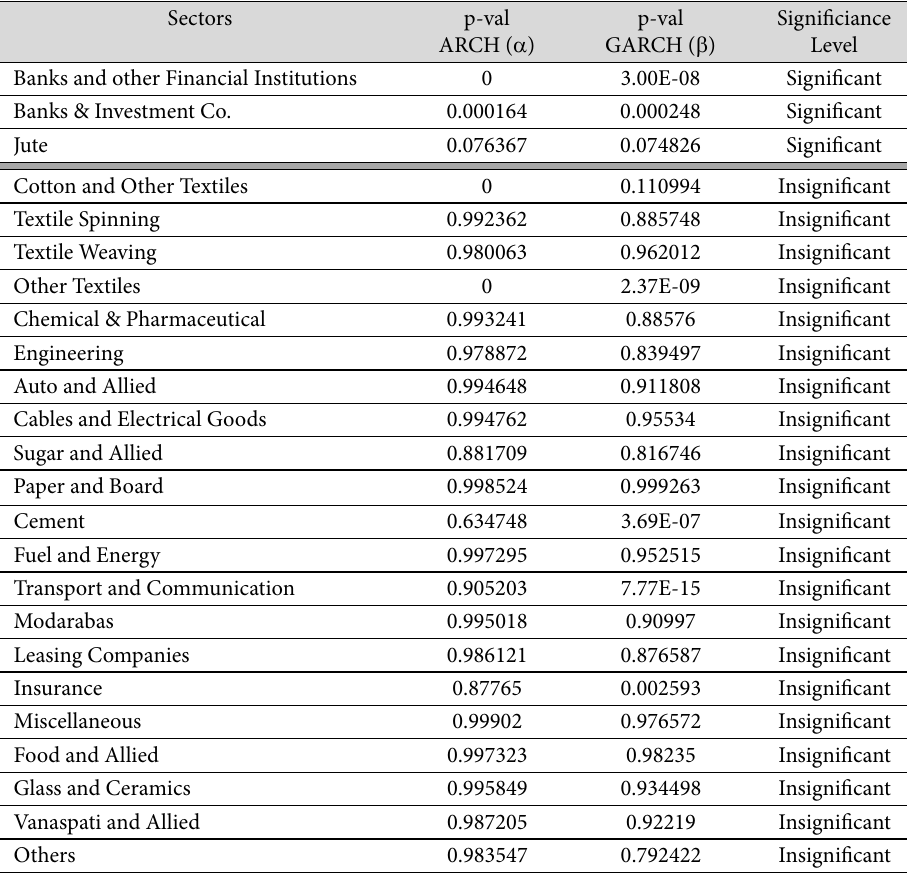
Table 3. Significant and insignificant ARCH & GARCH